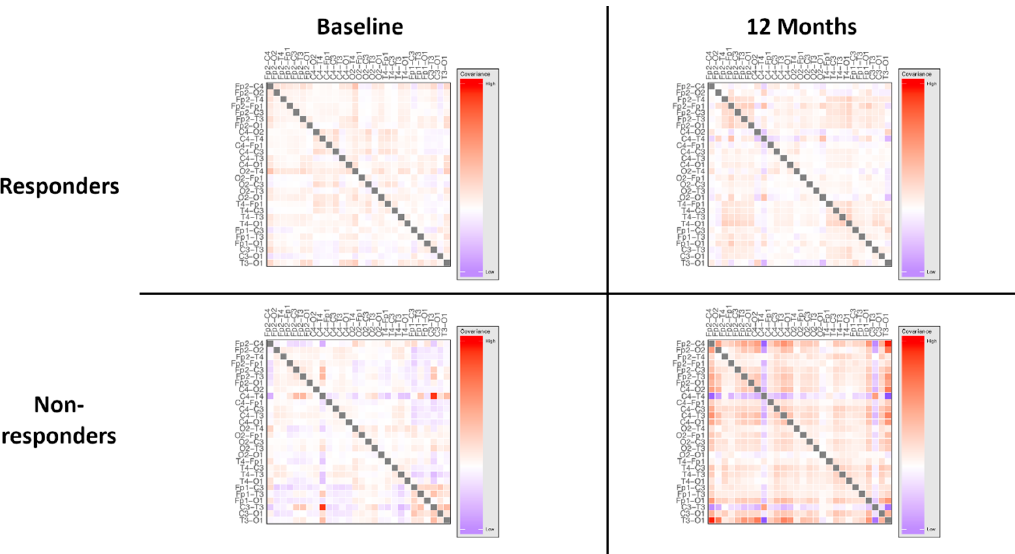
Figure 5. Schematic of network architecture at baseline and at twelve months, responders vs. nonresponders. ANOVA of network loadings (principal components of network